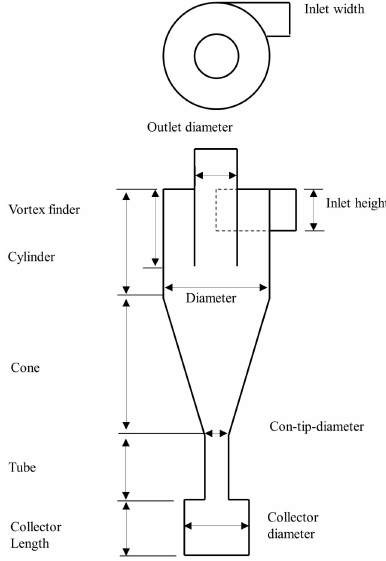
Figure 5. Geometric schematic diagram. Table 3. Geometric parameter